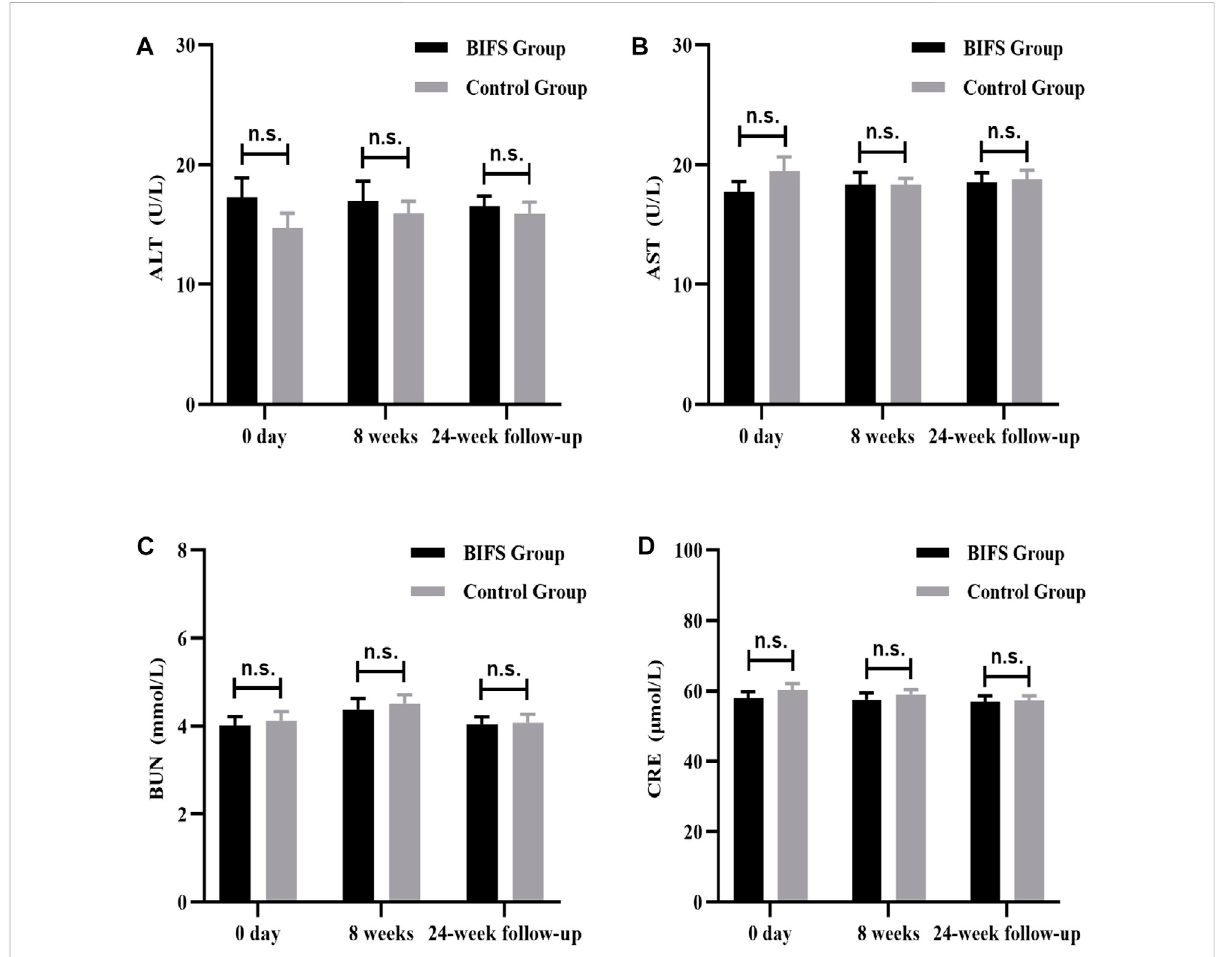
FIGURE 9 Liver and kidney functions at baseline, after eight treatment weeks, and at 24-week follow-up. (A) ALT, (B) AST, (C) BUN, (D) CRE. n.s., no statistically signi fi cant difference, * p < 0.05, ** p <